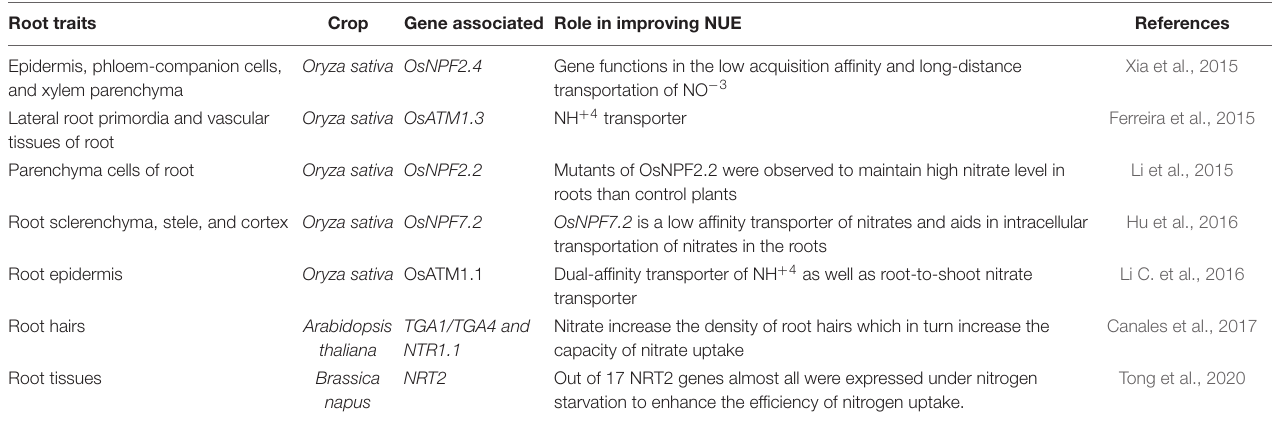
TABLE 3 | Crucial root traits associated with improved nitrogen use